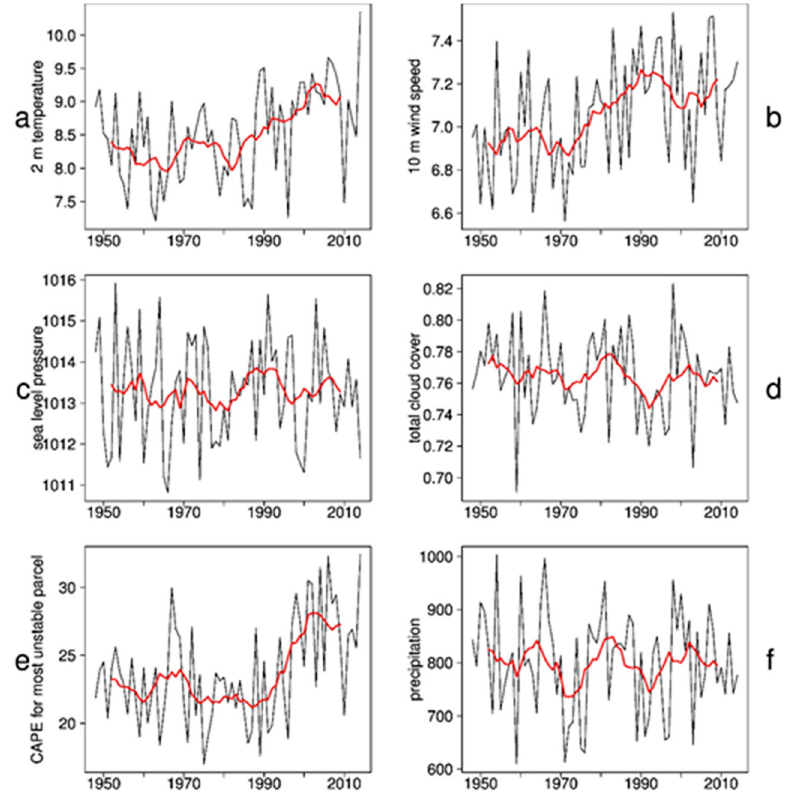
Figure 2. GB0028 time series over 67 years (black) with 10 years running mean (red) of ( a ) annual mean 2 m temperature, ( b ) annual mean 10 m wind speed, ( c ) annual mean sea level pressure, ( d ) annual mean total cloud cover, ( e ) annual mean CAPE, ( f ) annual sum of precipitation.